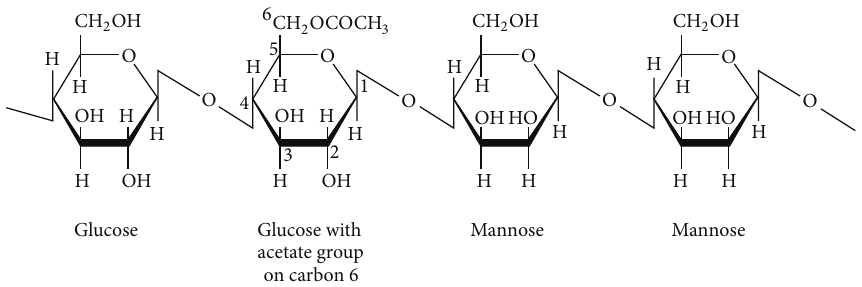
Figure 1: Structure of a segment of glucomannan with repeating glucose and mannose